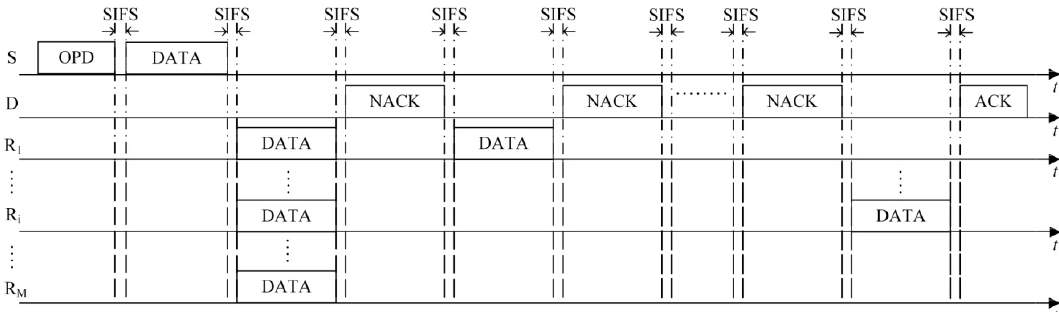
Figure 7. Successful data packet transmission after one-time retransmission.